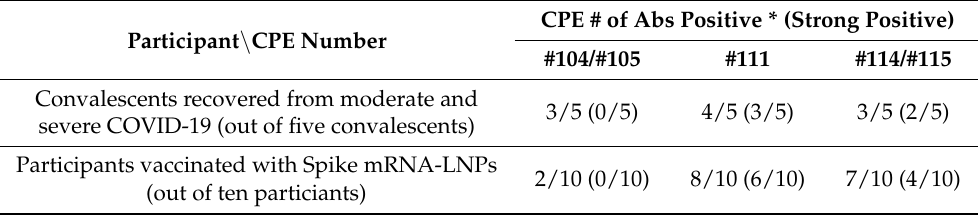
Table 1. Common epitopes in S2-HR1/2 region recognized by convalescents’ sera and sera of recipients vaccinated twice with Spike mRNA. CPE # of Abs Positive * (Strong Positive) Participant \ CPE Number #104/#105 #111 #114/#115 Convalescents recovered from moderate and 3/5 (0/5) 4/5 (3/5) 3/5 (2/5) severe COVID-19 (out of five convalescents) Participants vaccinated with Spike mRNA-LNPs 2/10 (0/10) 8/10 (6/10) 7/10 (out of ten particiants)